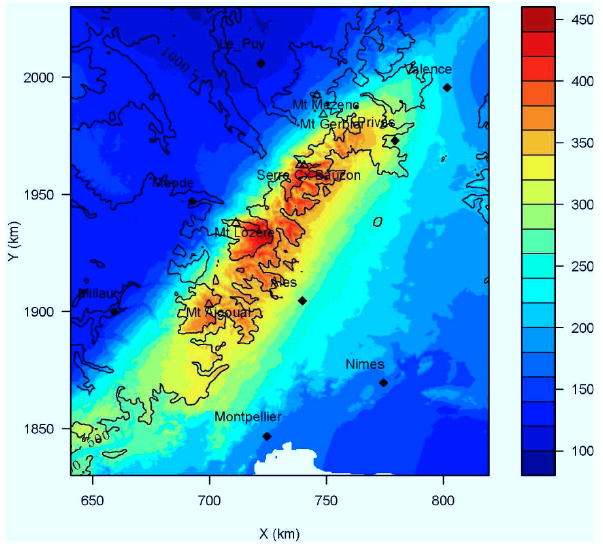
Fig. 7. 100-yr return levels estimated by RS2 on the C´evennes- Vivarais data (mm).